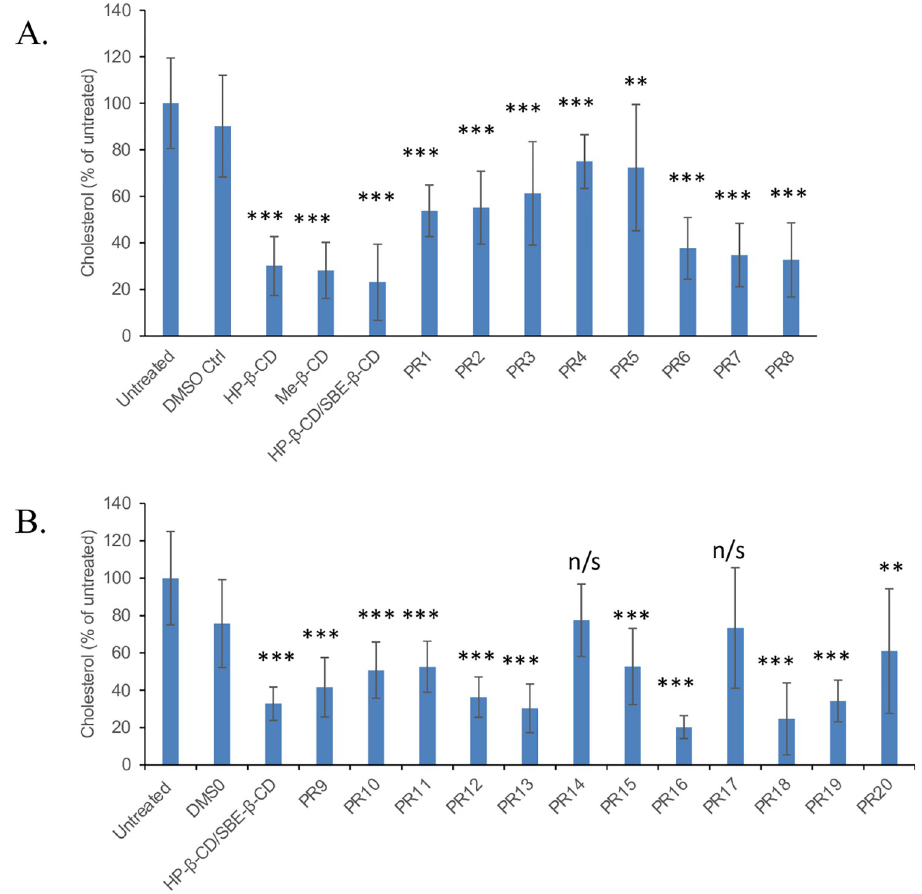
Fig 1. Cholesterol accumulation in NPC1-deficient cells as determined by filipin III staining after exposure to polyrotaxanes for 24 h at 25 μ M equivalent β -CD monomer concentration. A. Controls and polyrotaxanes PR1 – PR8 prepared by the solvent-assisted method. B. Controls and polyrotaxanes PR9 – PR20 prepared by solid state mechanochemical synthesis. Data are expressed relative to DMSO-treated controls and are an average +/- S.D. of two separate experiments with 30 cells imaged per condition in each experiment. (t-test vs. DMSO control, �� p < 0.01; ��� p < 0.001). Inclusion of SBE- β -CD in the HP- β -CD polyrotaxane formulation was intended to boost the PR solubility in physiological saline solutions [19, 39]. Cholesterol mobilization improved when SBE- β -CD was included in the polyrotaxane scaffold. Our results show that PR6 and PR8 produced cholesterol mobilization levels that were almost as effective as the monomeric β -CD controls. Direct comparison of PR4 (6 HP- β -CD) and PR6 (4 HP- β -CD and 2 SBE- β - CD), both having the same total number of β -CD threaded onto a Pluronic L35 core, shows that inclusion of SBE- β -CD boosted sterol clearance from the endo-lysosomal compartment by approximately 60% of control, while the compound with HP- β -CD alone led to mobiliza- tion by only about 25%. The same trend is apparent for PR3 and PR8 with Pluronic L81 cores, where threading of HP- β -CD along with SBE- β -CD lowers the accumulated cholesterol by 70% compared to untreated NPC1 deficient cells, while the compound with HP- β -CD alone reduced sterol by 40%. We infer from these findings that, as intended, the solubility enhance- ment provided by inclusion of SBE- β -CD units can substantially improve the performance of the polyrotaxanes [40, 41]. Interestingly, the length of the polymer chain and number of CDs